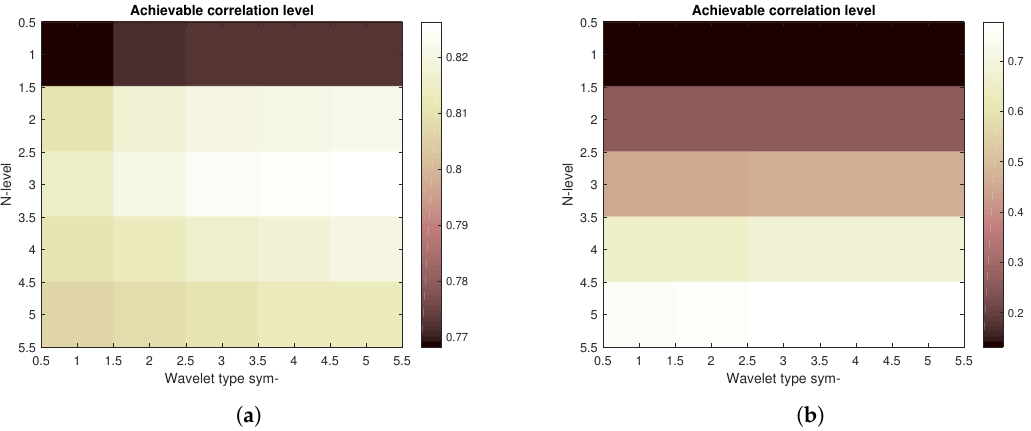
Figure 8. Achievable correlation level for different combinations of Symlet mother wavelet order and decomposition level for lower ( a ) and higher ( b ) amount of added artificial